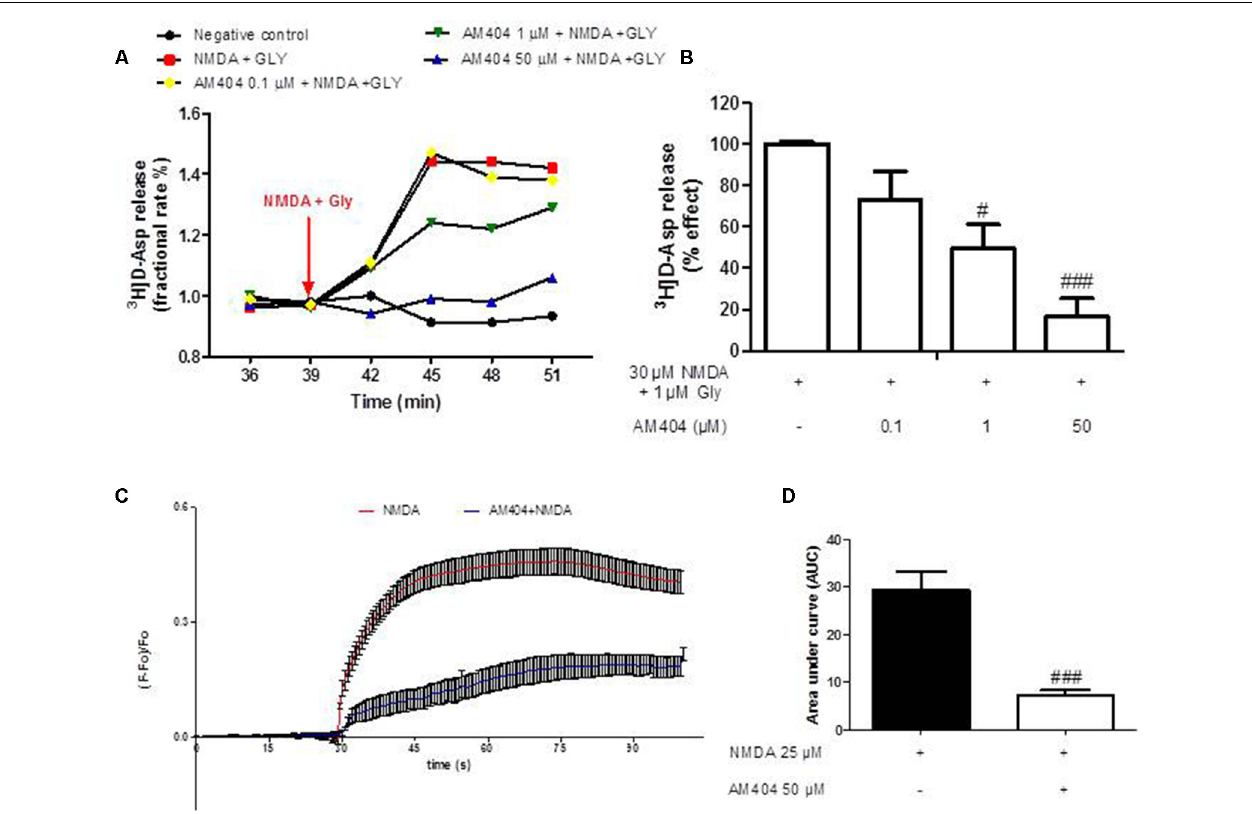
FIGURE 2 | Effects of AM404 on [ 3 H]D-Asp release in hippocampal synaptosomes and intracellular Ca 2 + responses. (A) Time course of [ 3 H]D-Asp release induced by NMDA plus Gly and effects of AM404 in hippocampal synaptosomes. Results are expressed as fractional rate percent. (B) AM404 inhibition of the NMDA plus Glycine-evoked-[ 3 H]D-Asp release in hippocampal synaptosomes. (C) Data of calcium imaging expressed as fluorescence intensity ( ∆ F/F baseline) vs. time. (D) Data of calcium imaging calculated the area under the curve (AUC). Data are means ± SEM of three independent experiments. # p < 0.05 and ### p < 0.001 compared to NMDA (one-way ANOVA followed by Bonferroni post hoc tests for [ 3 H]D-Asp release and unpaired t -test of three independent experiments for calcium